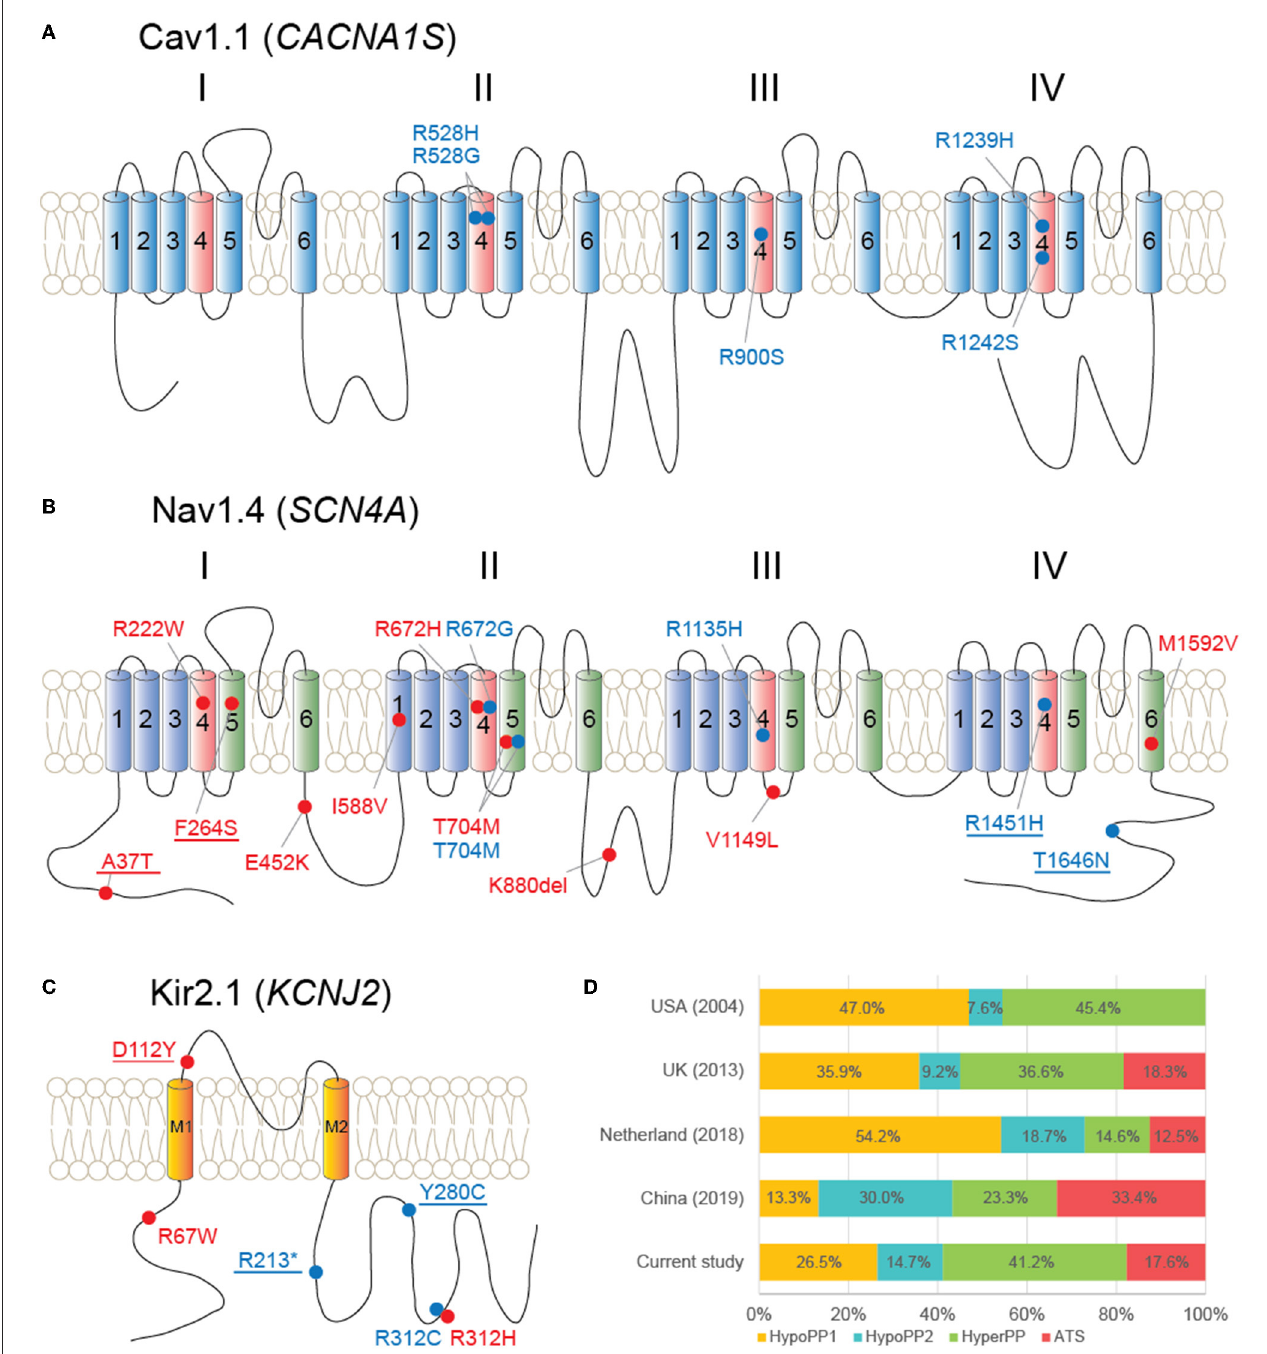
FIGURE3 Schematic diagrams of proteins and variants detected in this study and literature review. (A) Cav1.1 protein and five variants locate at its voltage–sensor domains (light red color). (B) Nav1.4 and 14 variants scatter throughout the protein. (C) Kir2.1 and location of six variants. Red dot and label: hyperPP phenotype; blue dot and label: hypoPP phenotype; underline: novel variants. (D) Literature review of genetic proportions from large-group studies of multiple countries, covering all CACNA1S , SCN4A , and KCNJ2